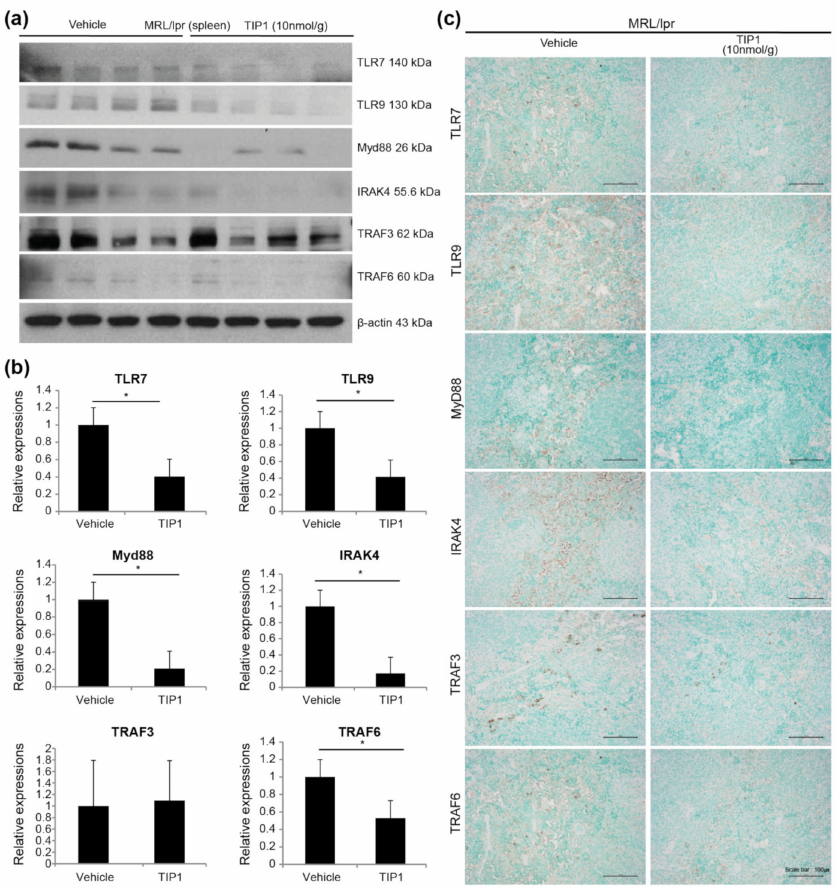
Figure 4. Toll-like receptor inhibitor peptide 1 (TIP1) blocks the endosomal Toll-like receptor 7 (TLR7)/TLR9 signaling pathway in the spleen. ( a ) The expression of the proteins of the endoso- mal TLR signaling was analyzed by Western blotting using spleen tissues from female lupus-prone mice (MRL/ lpr ). ( b ) The summarized bar graph shows the band intensity presented as the ratio of the target protein to actin (n = 4 mice/group). Values are means ± standard deviation (SD). * p < 0.05 by Mann–Whitney U test. ( c ) Immunohistochemistry was performed to detect endosomal TLR pathway proteins (brown) in the spleen (magnification, × 20). The experiments were repeated at least twice. MyD88, myeloid differentiation factor 88; IRAK4, interleukin-1 receptor-associated kinase 4; TRAF3, tumor necrosis factor receptor-associated factor 3; TRAF6, tumor necrosis factor receptor-associated factor